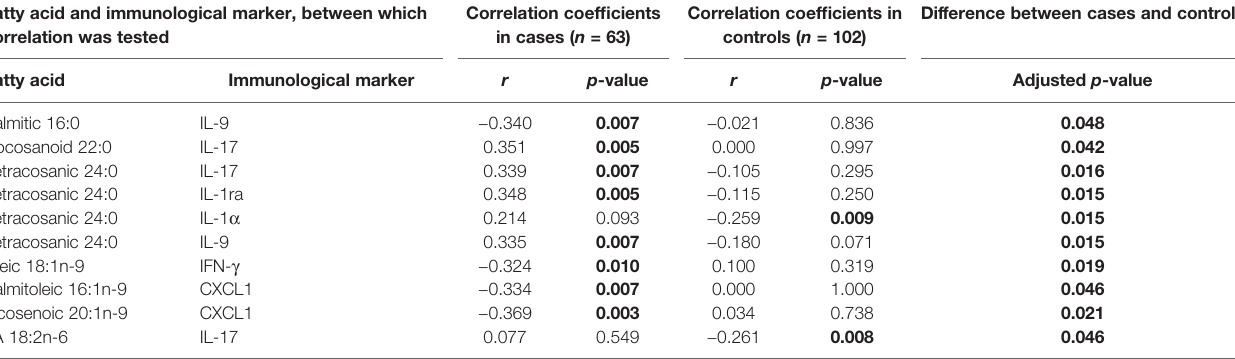
TABLE 4 | Differences in Spearman correlation coef fi cients between serum fatty acids and immunological markers at 12 months of age by case – control status. Fatty acid and immunological marker, between which correlation was tested